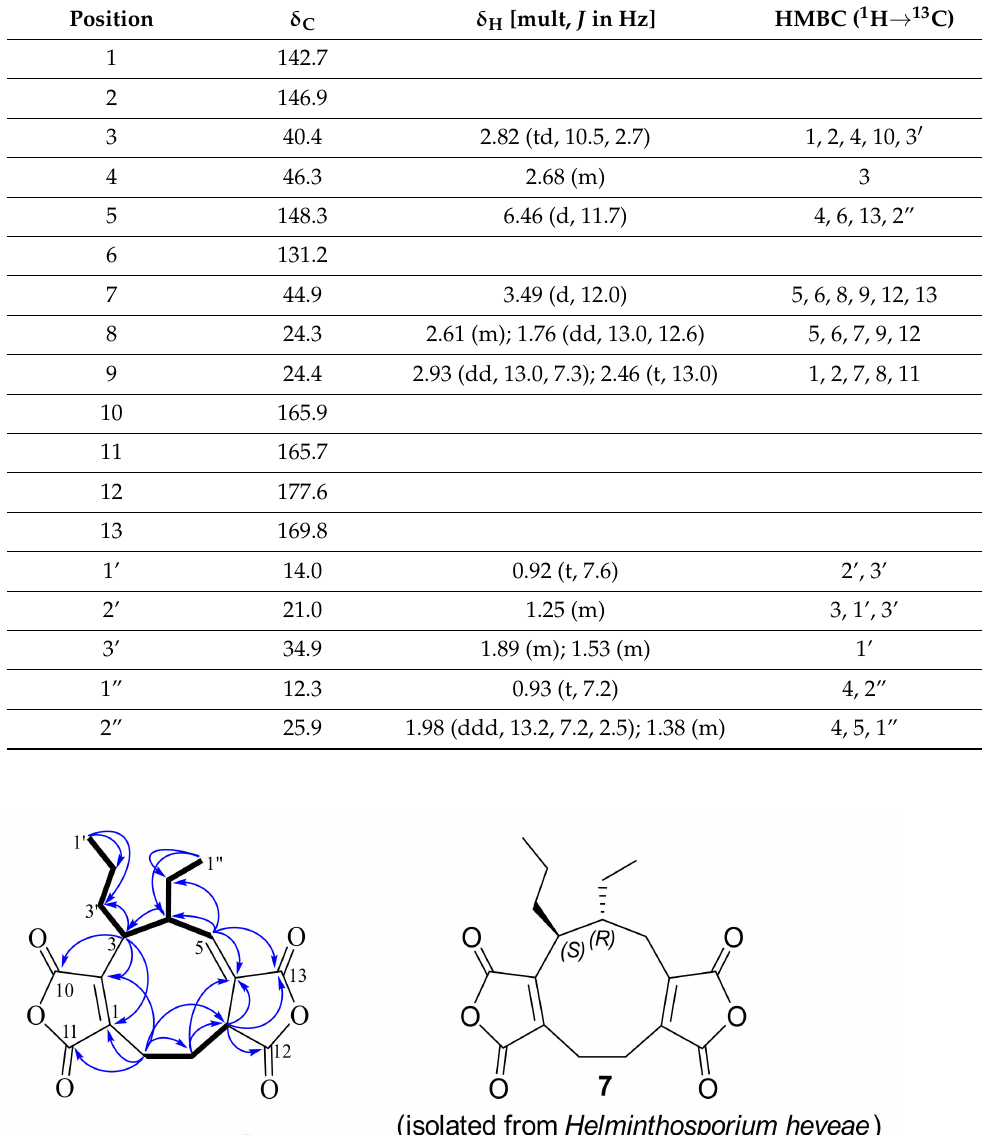
Table 1. 1 H (400 MHz, CDCl 3 ) and 13 C (100 MHz, CDCl 3 ) NMR Spectroscopic data of curvularia- hawadride ( 5 ).